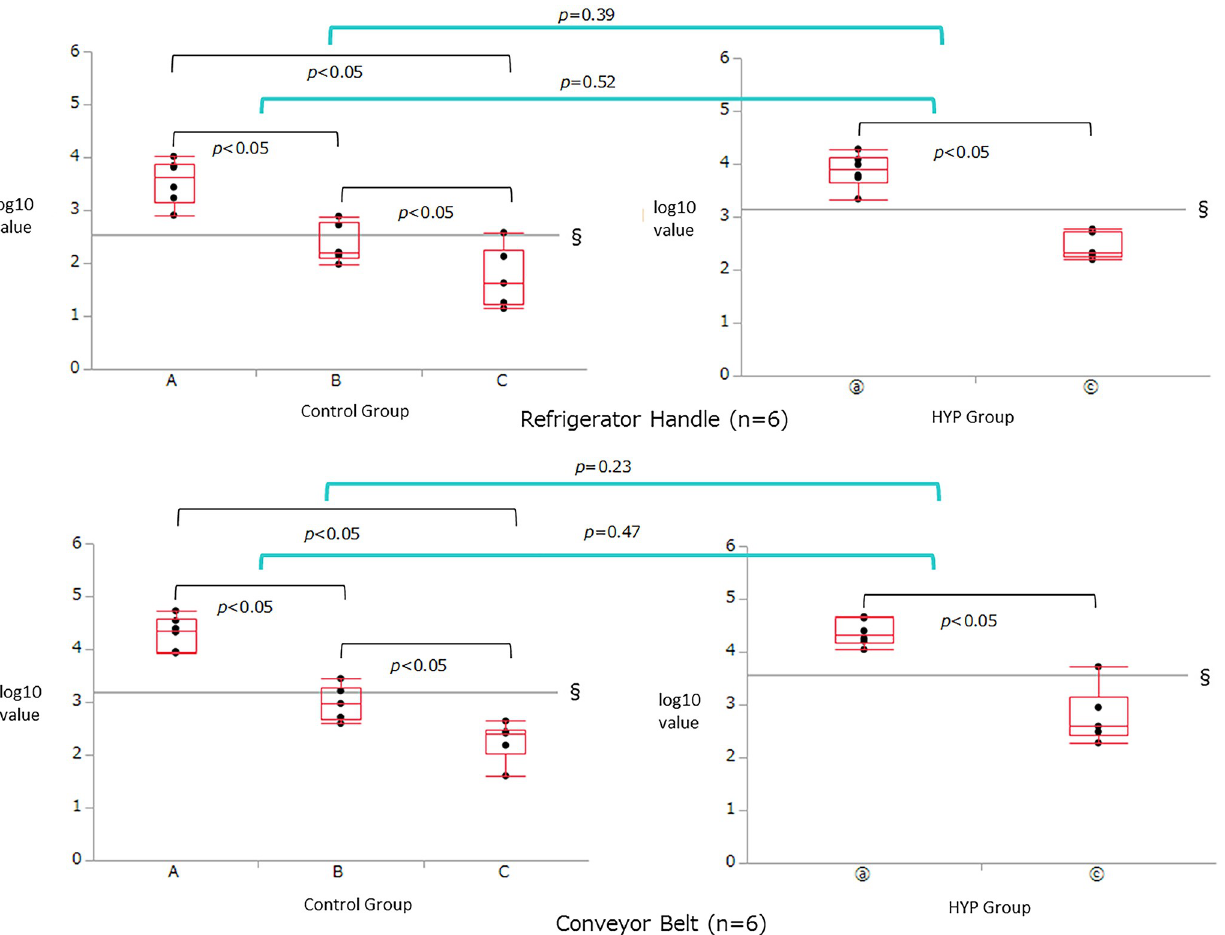
Fig 3. Inter-group comparison of the relative light unit (RLU) and log 10 values in the refrigerator handle and conveyor belt test locations measured by adenosine triphosphate (ATP) swab testing. There were significant improvements in the log 10 values of the RLUs from the pre-disinfecting (A) to post-surfactant swab (B) and the post-HYP swab (C) for the control group, and from the pre-disinfecting ( ⓐ ) to post-HYP swab ( ⓒ ) for the HYP group ( p < 0.05). Significant differences in the log 10 values of the RLUs between the post-surfactant swab (B) and post-HYP swab (C) for the control group were observed at the refrigerator handle and conveyor belt ( p < 0.05). In both these locations, there were no significant differences in the change in log 10 values of the RLUs between the post-HYP swab ( ⓒ ) of the HYP group and the post-surfactant swab (B) and post-HYP swab (C) of the control group.